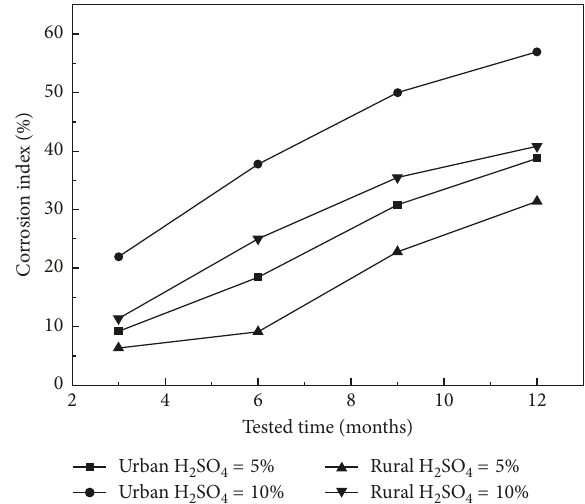
Figure 7: Variation of corrosion index K -value with the tested